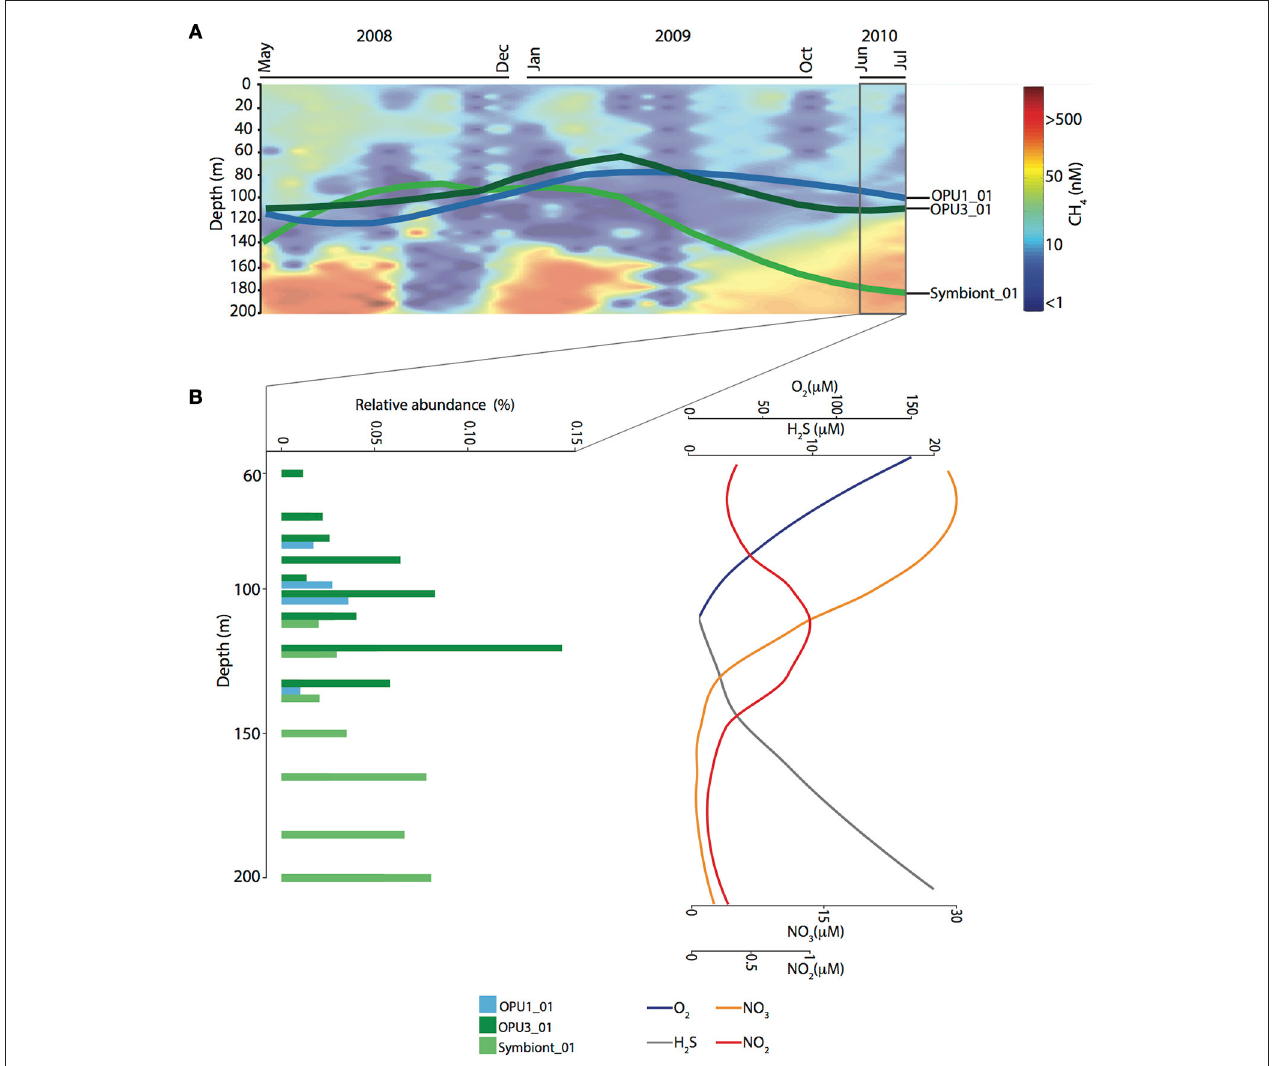
FIGURE 4 | Time-series observations for methanotrophic OTUs affiliated with OPU1, OPU3, and methanotrophic symbiont groups. (A) Methane contour plot for gas concentration (nM) data throughout water column from May 2008 to July 2010. Overlapped is shown the OTUs distribution mean trend throughout water column over time. (B) Vertical distribution and relative abundance of methanotrophic OTUs over extended stratification period (June–July 2010). On the right, sparklines depict concentration trend for Oxygen (O 2 ), Sulfide (H 2 S), Nitrate (NO − 3 ), and Nitrite (NO − 2